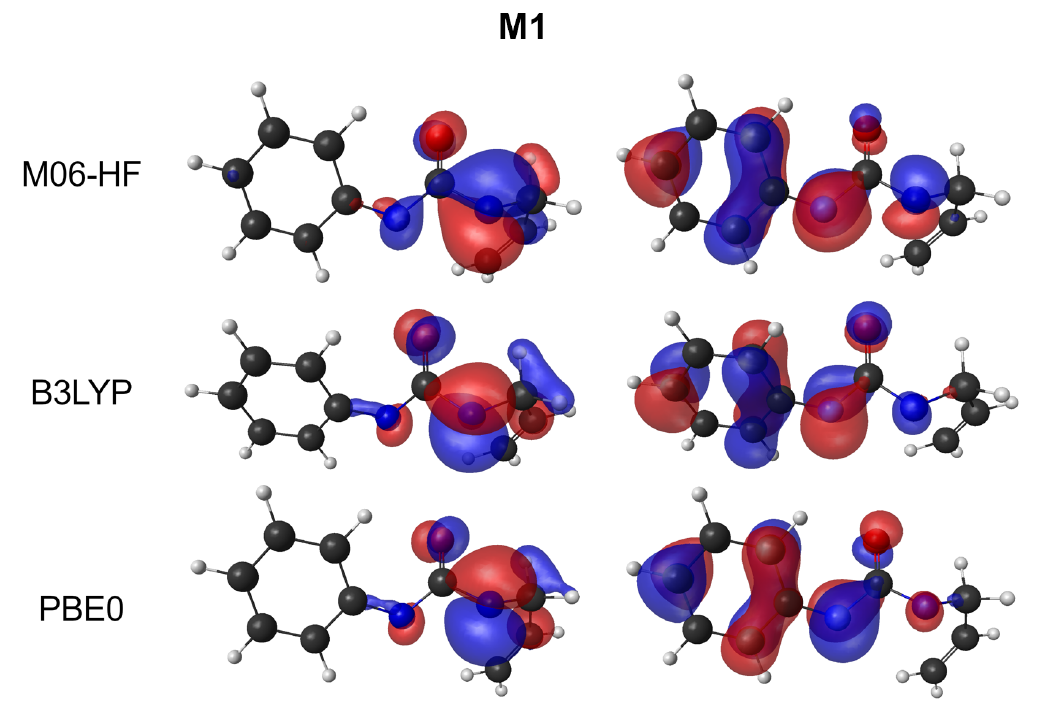
Figure 6. Semi-occupied orbitals of the M1 structure for the three functionals. The transition states TS1 and TS2 have been located 354.5–458.9 kJ mol − 1 and 223.2– 340.6 kJ mol − 1 above S 0 according to the functional used. As previously shown, the B3LYP reveals the lower value and the M06-HF the higher, but considering the reaction path, ∆ E ‡ = E TS1 − E T and ∆ E ‡ = E TS2 − E M 0 , the TS1 in B3LYP has the larger barrier- 1 height ( 72.1 kcal mol − 1 ) and the lower relative energy barrier value ( 3.8 kcal mol − 1 ) for the M0 → M1 reaction. The vibrational analysis of the orthogonal normal mode relative to the reaction path is 398 i and 879 i for TS1 and TS2, respectively, associated to a stretching of the NN bond. The transition-state distances have been determined as R 12 − 13 = 1.7214 Å for TS1 and R 15 − 16 = 1.61575 Å. The energy profile of this mechanism can be better seen on Figure 7. After the extrusion of N 2 , the system undergoes a conformational rearrangement through the allylic group. The transition-state presents a barrier of 52.8 kJ mol − 1 , 56.2 kJ mol − 1 , and 65.5 kJ mol − 1 , for M06HF, PBE0, and B3LYP, respectively. Although the barrier height is larger than the extrusion of N 2 , the shape of reaction coordinate at the critical point, associated to the imaginary frequency 471 i cm − 1 , shows a wider acceptance cone. Note, like steps 1a and 1b, the relative energy of the B3LYP and larger energy barrier suggests a more stable M2